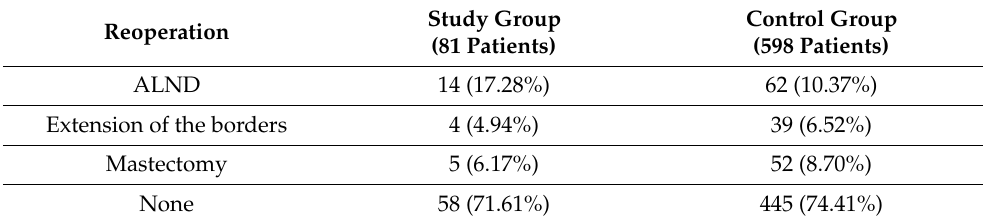
Table 3. Prevalence and types of surgical methods used during